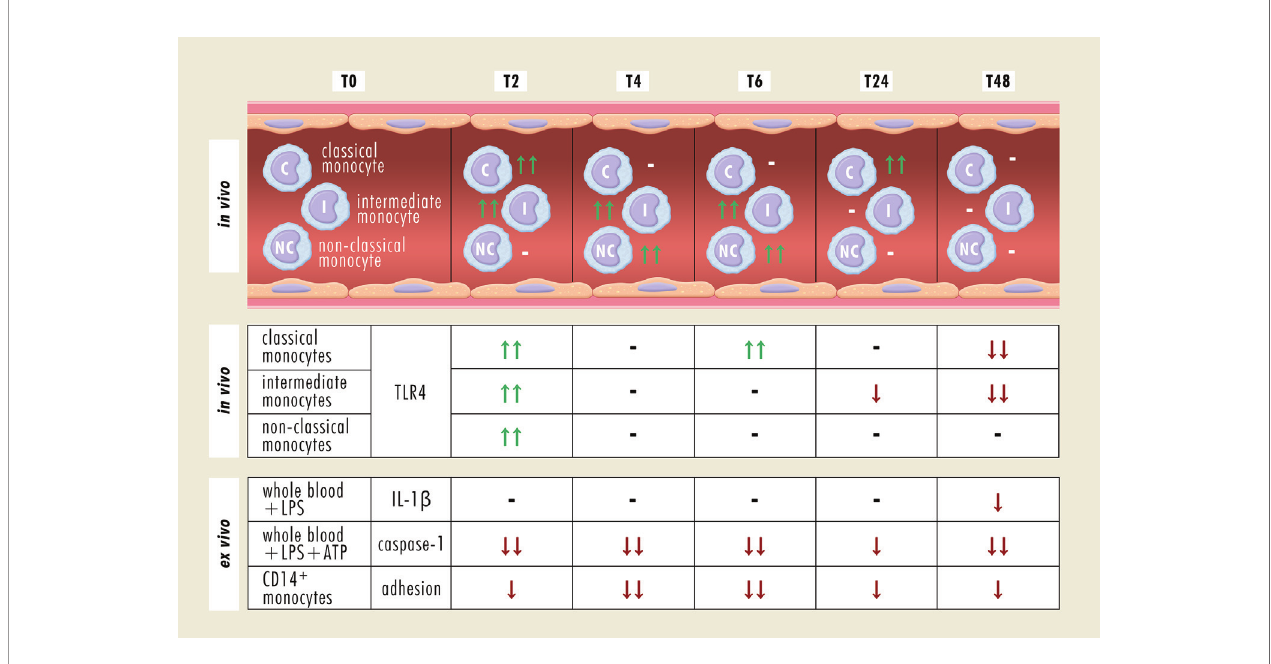
FIGURE 7 | Summary of phenotypical and functional changes of monocyte subsets following an acute alcohol intoxication. -, no change; ↑↑ , signi fi cant increase; ↓↓ , signi fi cant decrease; ↓ , decreasing trend; ATP, adenosine triphosphate; CD, cluster of differentiation; IL-1 b , Interleukine-1 b ; LPS, lipopolysaccharide; TLR4, Toll-like receptor